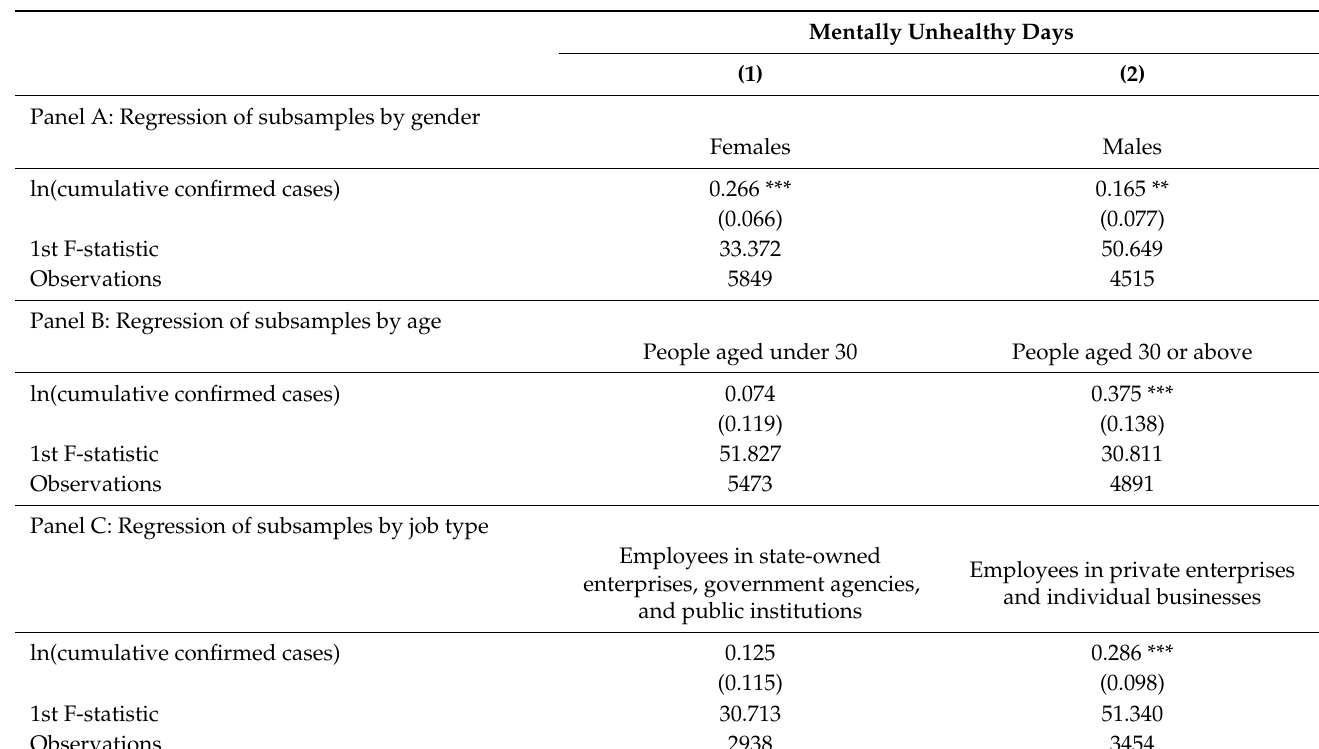
Table 4. Heterogeneity